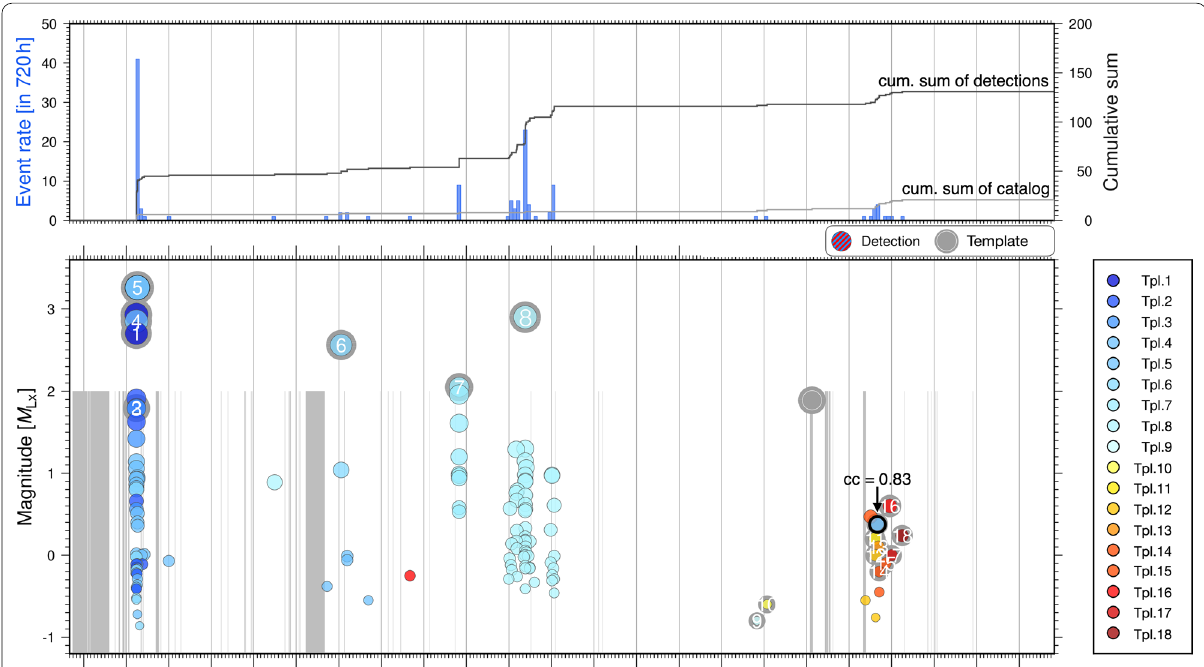
Fig. 3 Time line of template matching earthquake detections for station BOURR using using thresholds individually selected for each template family by visual inspection. Top panel: resolved event rate; the gray curves represent the cumulative number of events considering new detections (dark gray) and catalog events only (light gray). Coloring of events indicates to which template a detected event is most similar. Existing catalogue events are highlighted with a grey ring. A black ring indicates event 2017/08/30 05:56:32. Data gaps are indicated by vertical gray bars. Their height is a conservative estimate of the completeness magnitude of the SED catalog for the study area. Above this magnitude threshold earthquakes in the study area would have been detected without the template matching